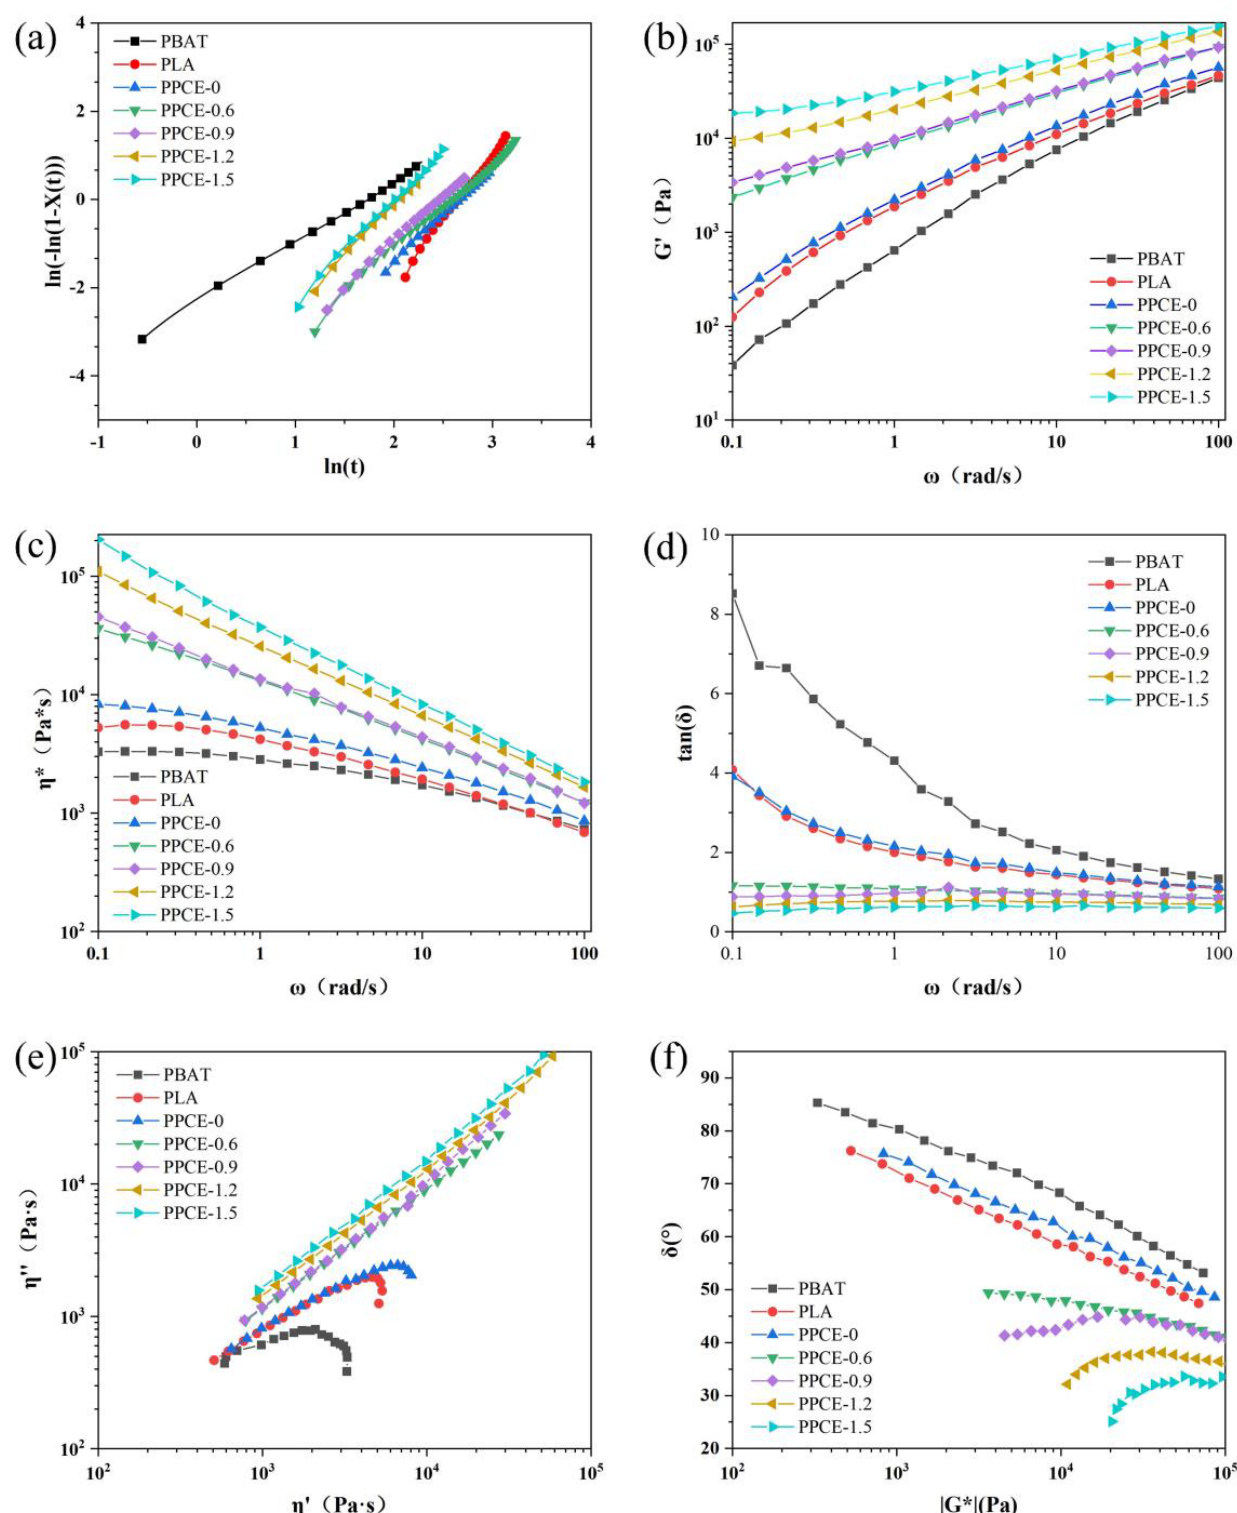
Figure 3. Characterization of samples: ( a ) Kinetics of crystallization of Avrami equation, ( b ) η*, ( c ) G’, ( d ) tan(δ), ( e ) Cole – Cole plots, and ( f ) vGP.